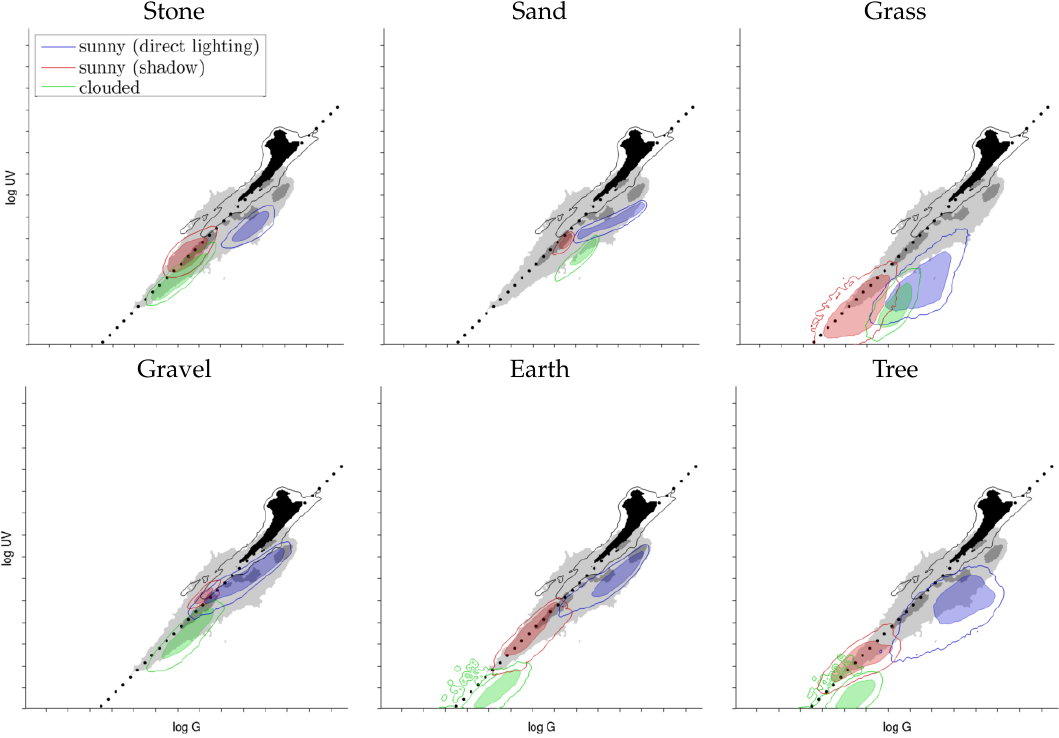
Figure 13. A total of 61 different samples of ground objects has been collected. This plot shows six different ground objects, each recorded under three different conditions: the object lies in the sun (blue) or in the shadow (red), both on a sunny day, or the object was recorded on a cloudy day (green). For comparison, the pooled data (ground and sky) from Figure 10 ( X 7–20 ) are shown together with the best 1:1 contrast separator ( w con , dotted line). Examples of the log UV/G data used to create the sand and grass plots are presented in Figure 6.